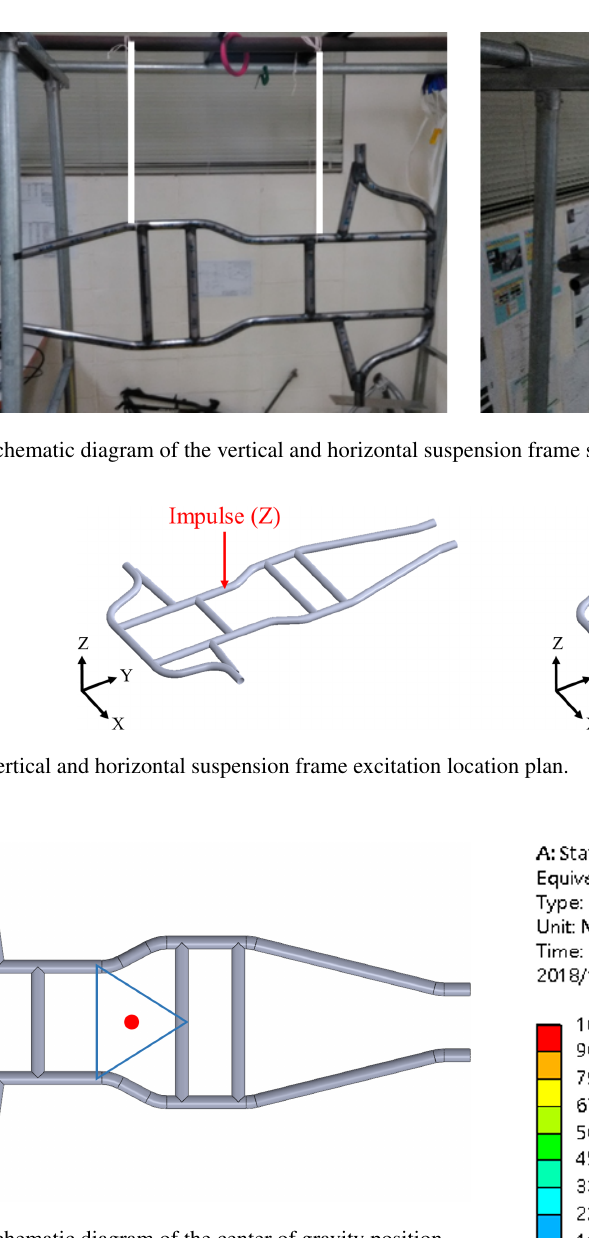
Figure 27. Schematic diagram of the center of gravity position.